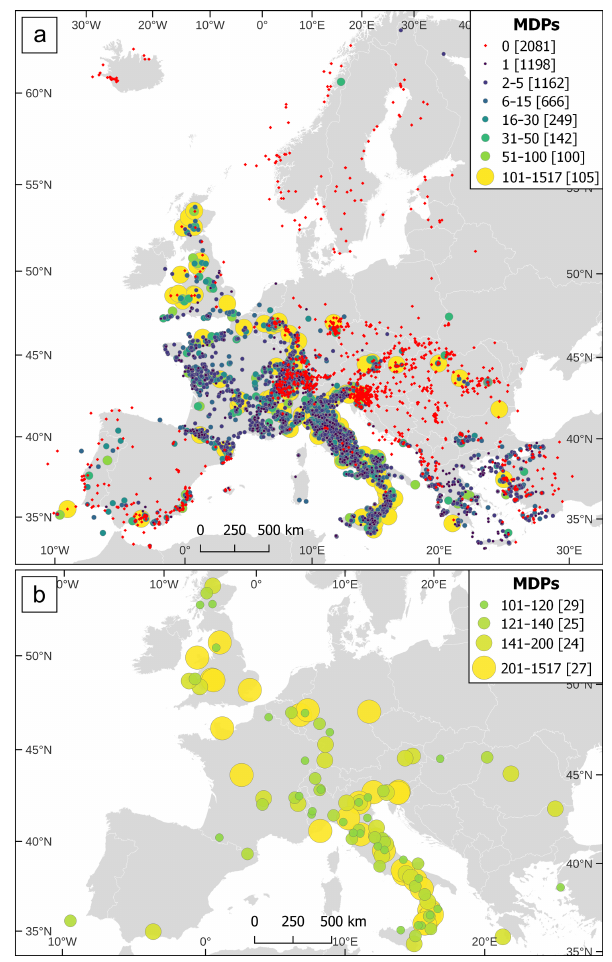
Figure 2. (a) Number of MDPs for each earthquake in EPICA, ac- cording to the selected dataset. MDPs = 0 means that MDPs are not available and a record from a parametric catalogue is selected. (b) Zoomed map of earthquakes with more than 100 MDPs. The number of earthquakes are indicated in brackets in the